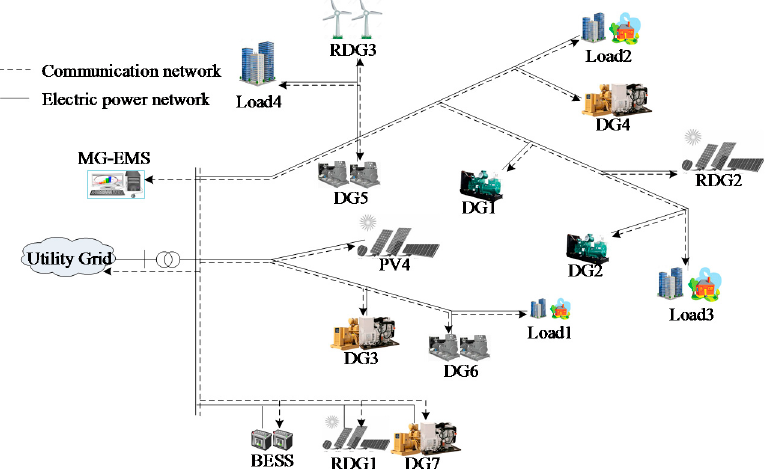
Figure 1. An illustration of a typical microgrid system.